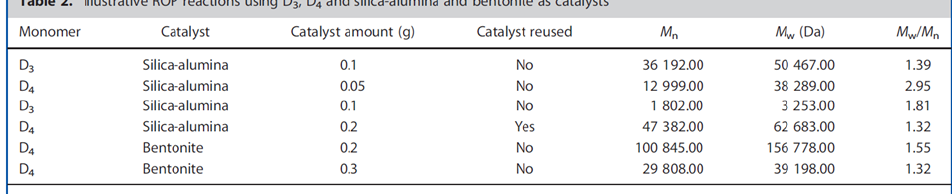
Figure 25. Polymerization of V 5 D 5 by Maghnite-H + . 2.2.2. Obtaining Siloxane Telechelics by CROP The CROP mechanism is used to obtain functional PDMS telechelics widely used in industry: hydride [131 – 133], mercaptopropyl [134], vinyl [135], as well as hydroxybutyl [136], carboxyl [137], and hydroxyl [138]. Today, PDMS-telechelics with “ standard ” functional groups are obtained for the pur- pose of their further modification [10]. Thus, Gorodov et al. obtained a series of hydride- containing polymers and copolymers by cationic polymerization of octamethylcyclotetra-